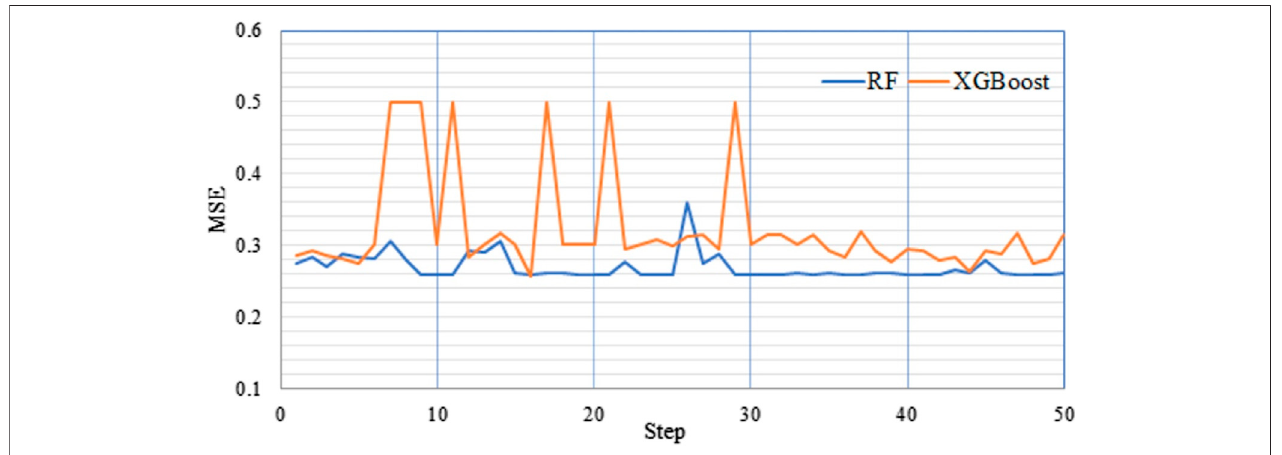
FIGURE 6 | RF and XGBoost hyperparameter optimization